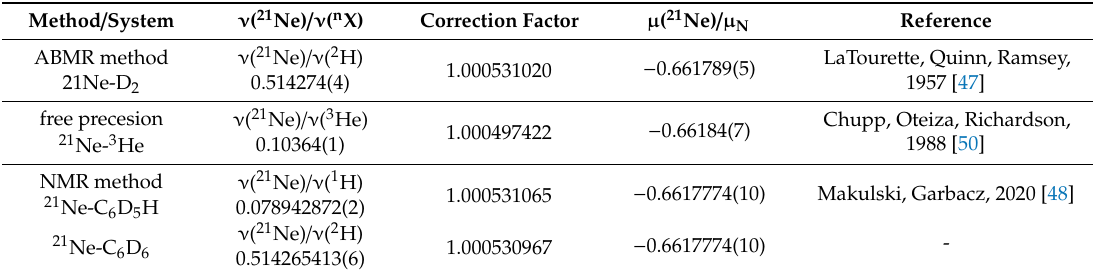
Table 2. Parameters for establishing of the neon-21 nuclear magnetic moment.